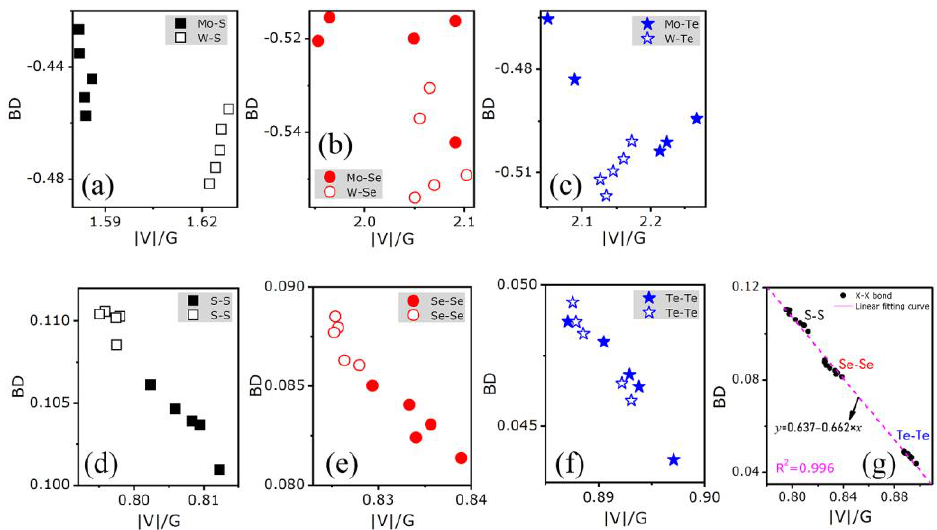
Figure 8. Bond degrees (BD) vs. |V|/G of M-X bonds in ( a ) MS 2 , ( b ) MSe 2 , ( c ) MTe 2 , and X-X bonds in ( d ) MS 2 , ( e ) MSe 2 , and ( f ) MTe 2 . Full symbol: Mo-containing bilayers; hollow symbols: W-containing bilayers. ( g ) Linear fitting result of BD vs. |V|/G of X-X bonds.